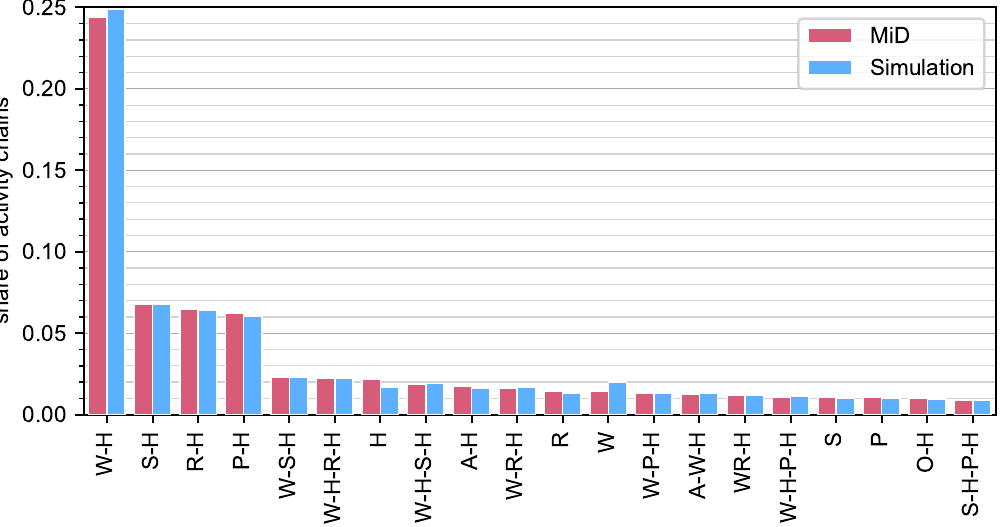
Figure 10. Share of partial activity chains. Comparison of simulation and MID. Activity types are abbreviated by their first letters (home = H, work = W, shopping = S, recreational = R, work-related = WR, private business—P, accompanying others = A, education = E, and other = O).